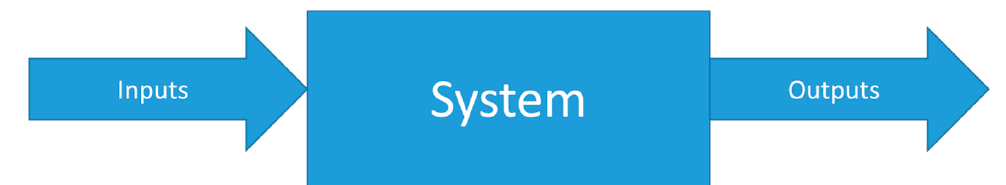
Figure 1. The depiction of the concept of system.